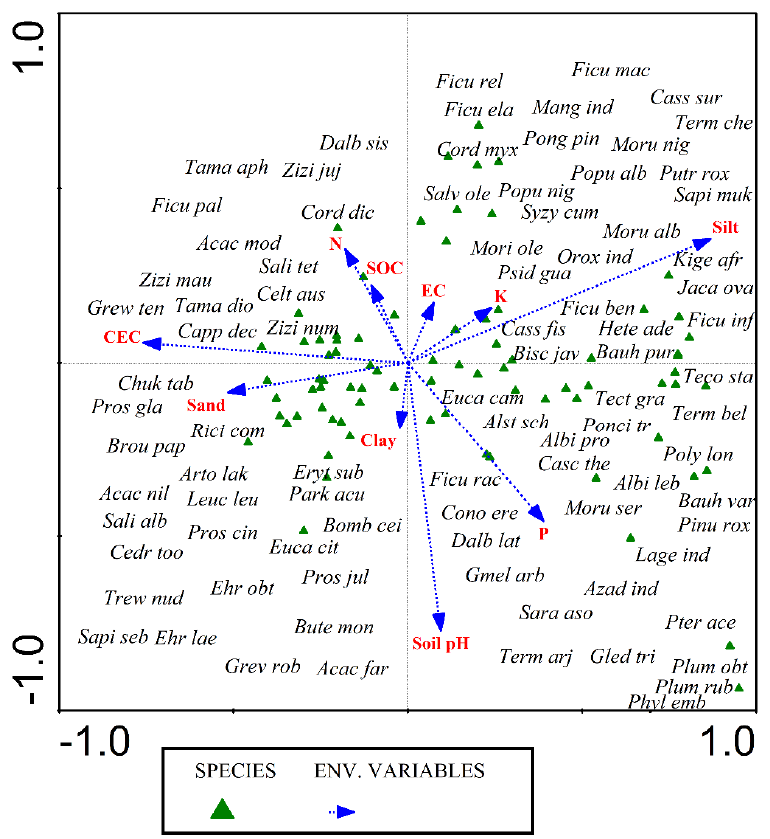
Figure 7. CCA analysis of woody vegetation in semi-arid lowland district Kasur Punjab, Pakistan. Table 2. Summary of CCA analysis of woody vegetation in semi-arid lowland of Punjab,